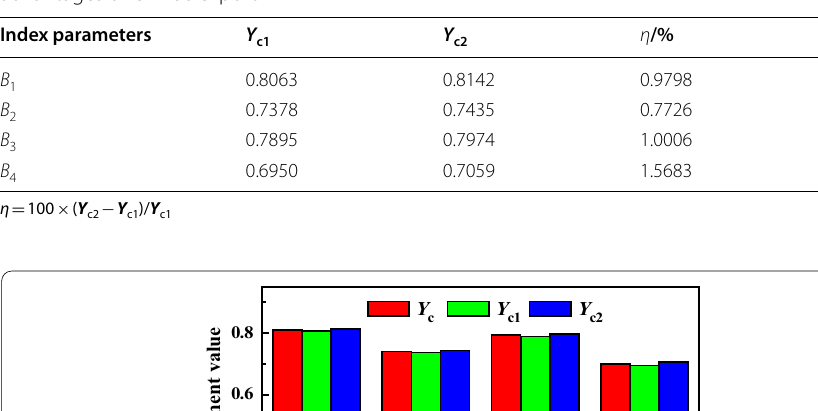
Table 6 Comparison of soft measurement values for key index parameters of new competitive advantages of China’s export